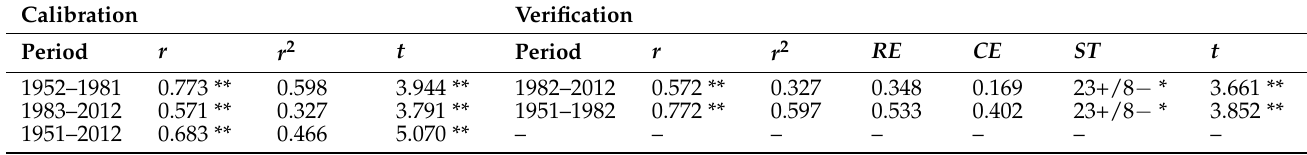
Table 2. The results of split calibration–verification